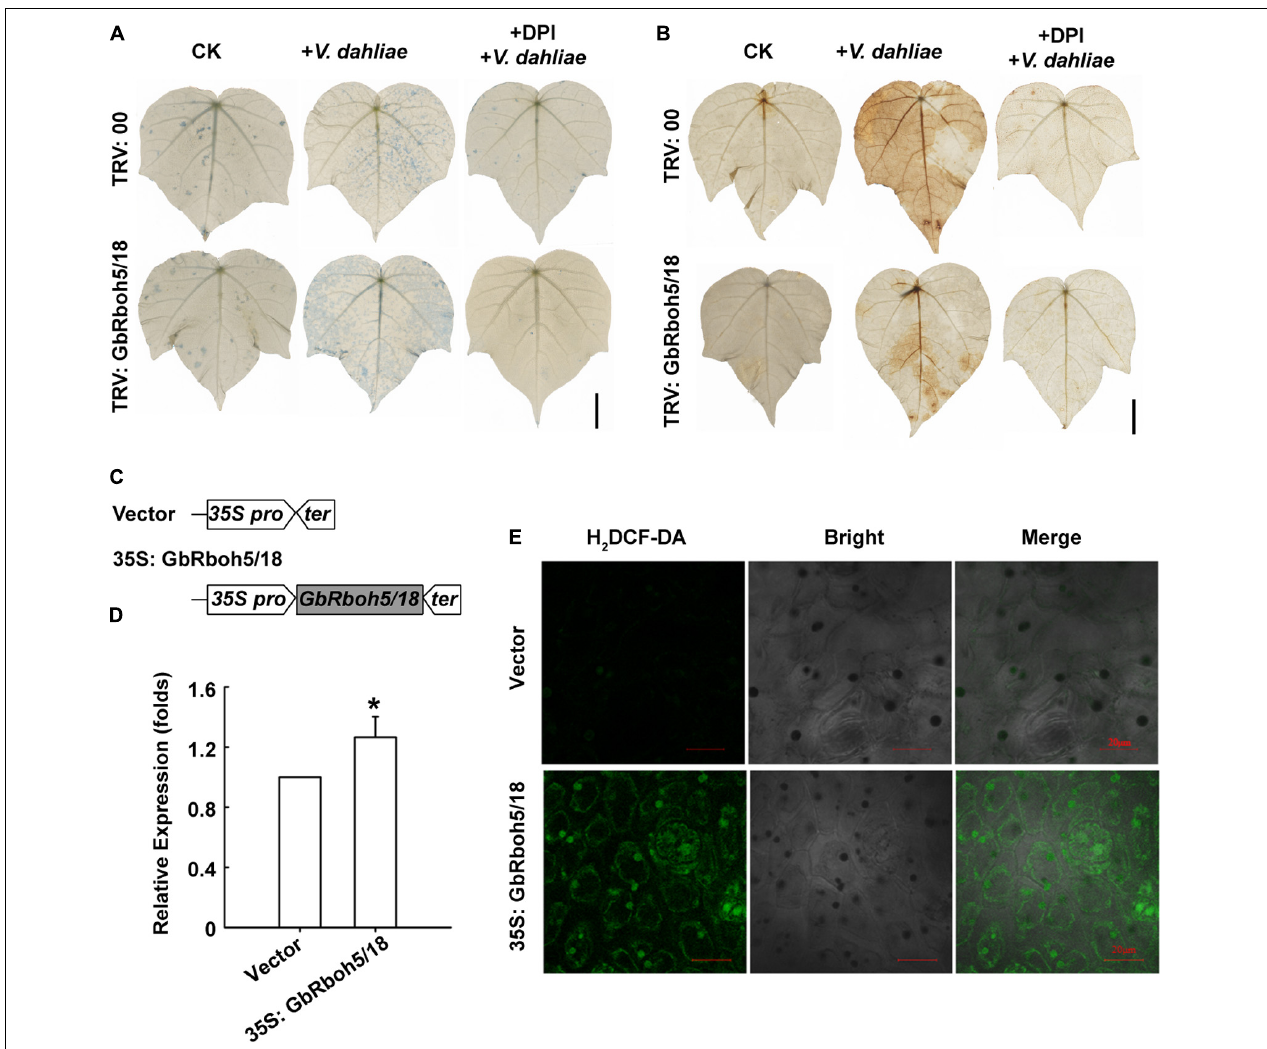
FIGURE 7 | GbRboh5/18 promotes ROS accumulation in G. barbadense . (A) Trypan blue staining of cell death and (B) DAB staining of ROS in GbRboh5/18 - VIGS and control leaves. Leaves were stained at 48 h post-inoculation with or without V. dahliae . Leaves were pretreated with or without 10 µ M DPI before trypan blue staining or DAB staining. Bar = 1 cm. (C) Schematic diagram showing the structure of overexpression vector. Gray-filled squares indicate ORF of GbRboh5/18 ; the left pentagon and right pentagon are the 35S promoter and 35S terminator, respectively. (D) Expression of GbRboh5/18 in GbRboh5/18-OE and vector plant leaves. UBQ7 was the internal reference gene. (* p < 0.05; Student’s t -tests). (E) H 2 DCF-DA fluorescence probe of ROS in GbRboh5/18-OE and vector leaves cells. Bar = 20 µ m. After 5 days of growth, the first true leaves were used to Q-PCR or H 2 DCF-DA staining. All experiments were repeated at least three times with similar